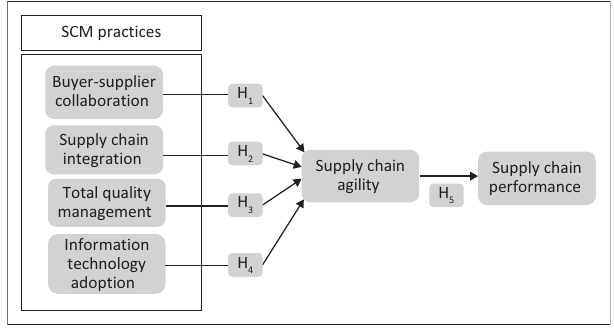
FIGURE 1: Conceptual